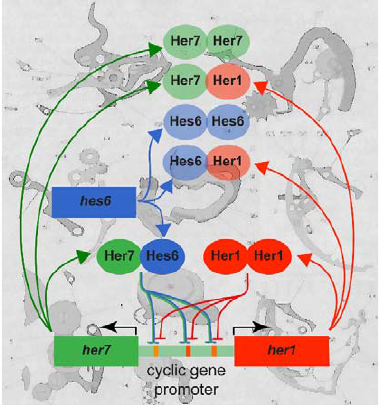
Selected PLoS Biology research articles are accom- panied by a synopsis written for a general audience to provide non-experts with insight into the significance of the published